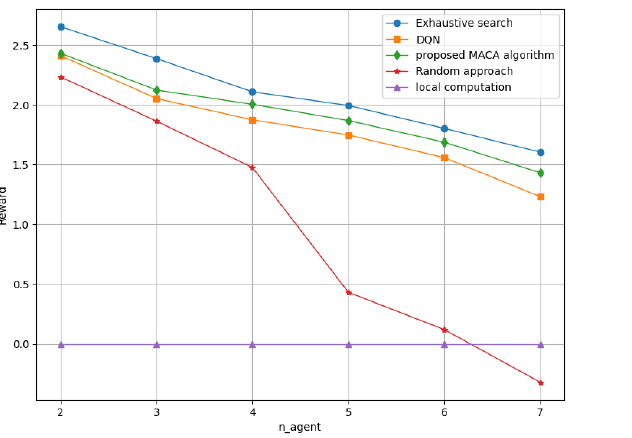
Figure 8. Algorithm performance varies with the number of agents. Table 2. The reward value varies with devices and computing nodes.